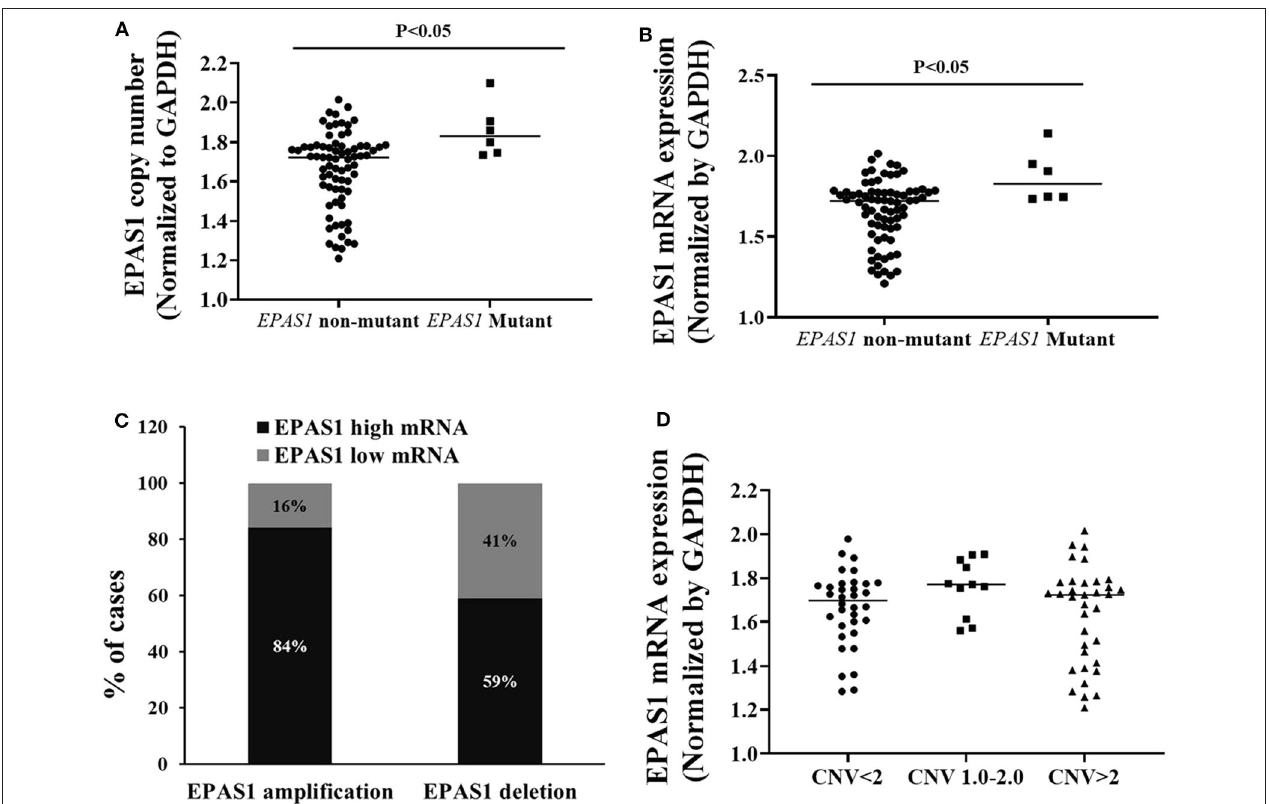
FIGURE 5 | Relationship of EPAS1 molecular dysregulation in ESCC. (A) EPAS1 -mutated samples showed significant amplification of DNA number in comparison to that of nonmutated samples ( p < 0.05). (B) Similarly, EPAS1 -mutated samples exhibited significant higher expression (mRNA) when compared to that of nonmutated tissue samples ( p < 0.05). (C) Association of EPAS1 DNA number changes and mRNA expression. RT-qPCR analysis revealed that EPAS1 DNA number amplification significantly correlated with mRNA overexpression ( p < 0.01). A 84% patients having EPAS1 DNA amplification showed mRNA overexpression whereas 59%